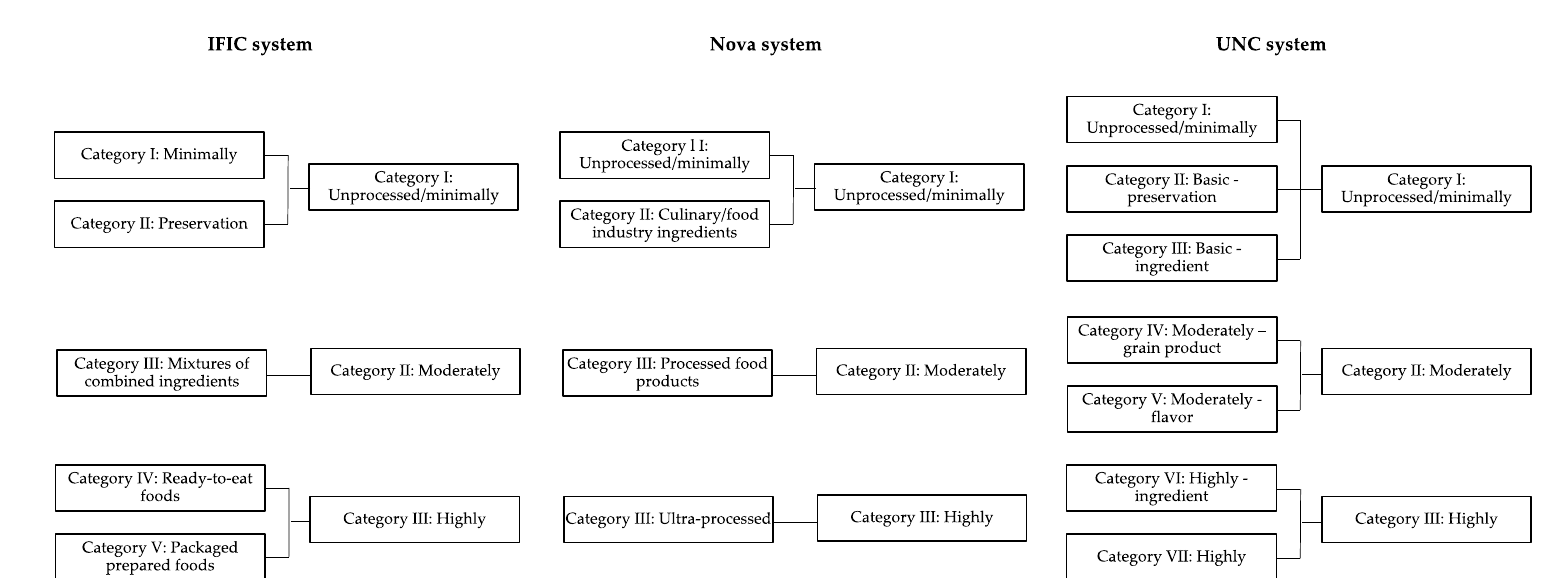
Figure 1. Original and final category assignment for foods as classified by the International Food Information Council (IFIC), Nova, and University of North Carolina at Chapel Hill (UNC) systems.